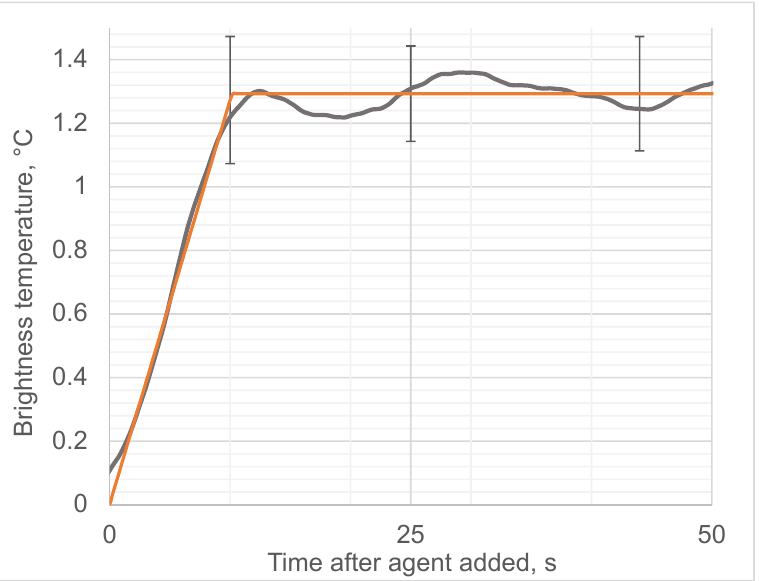
Figure 4. Microwave emissions (brightness) temperature of the egg white during ethanol-induced denaturation. Black line denotes experimentally observed temperature; red line denotes approximation (slope). Different panel figures refer to results from repeated experiments.